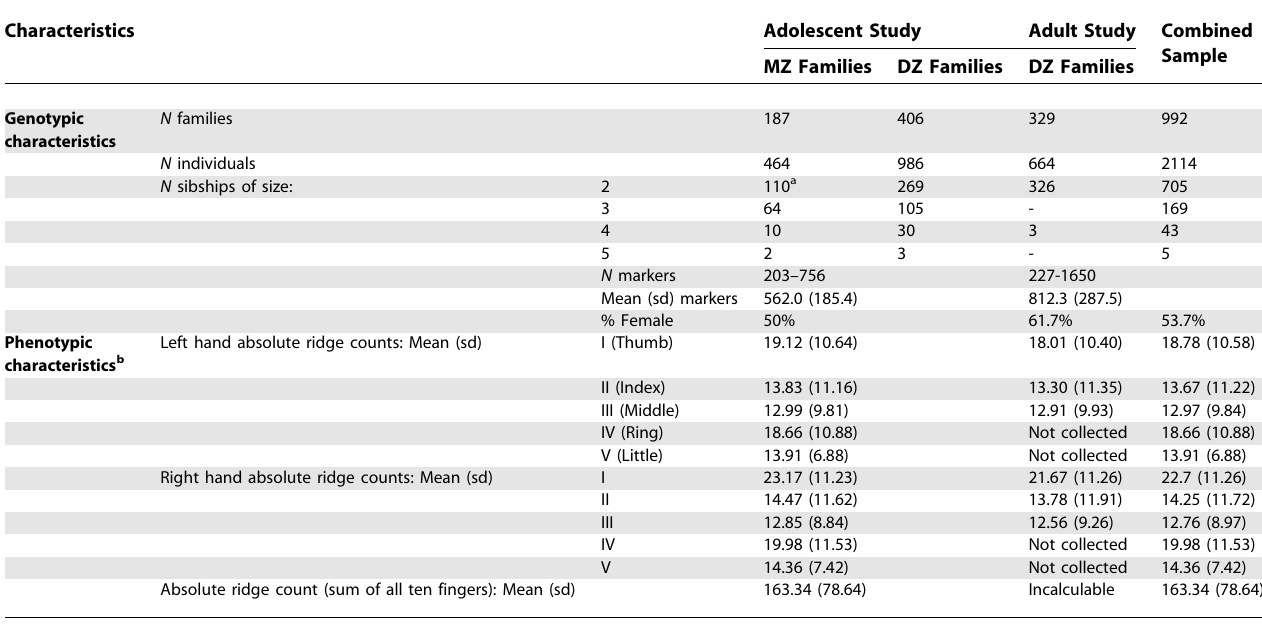
Table 3. Characteristics of Participants, Genotypic, and Phenotypic